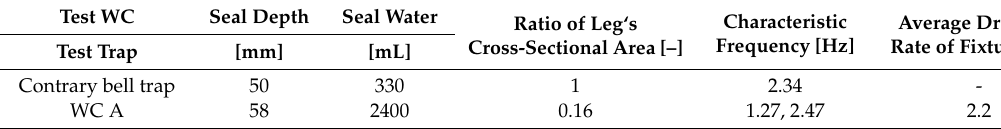
Table 3. Basic parameters of test traps.